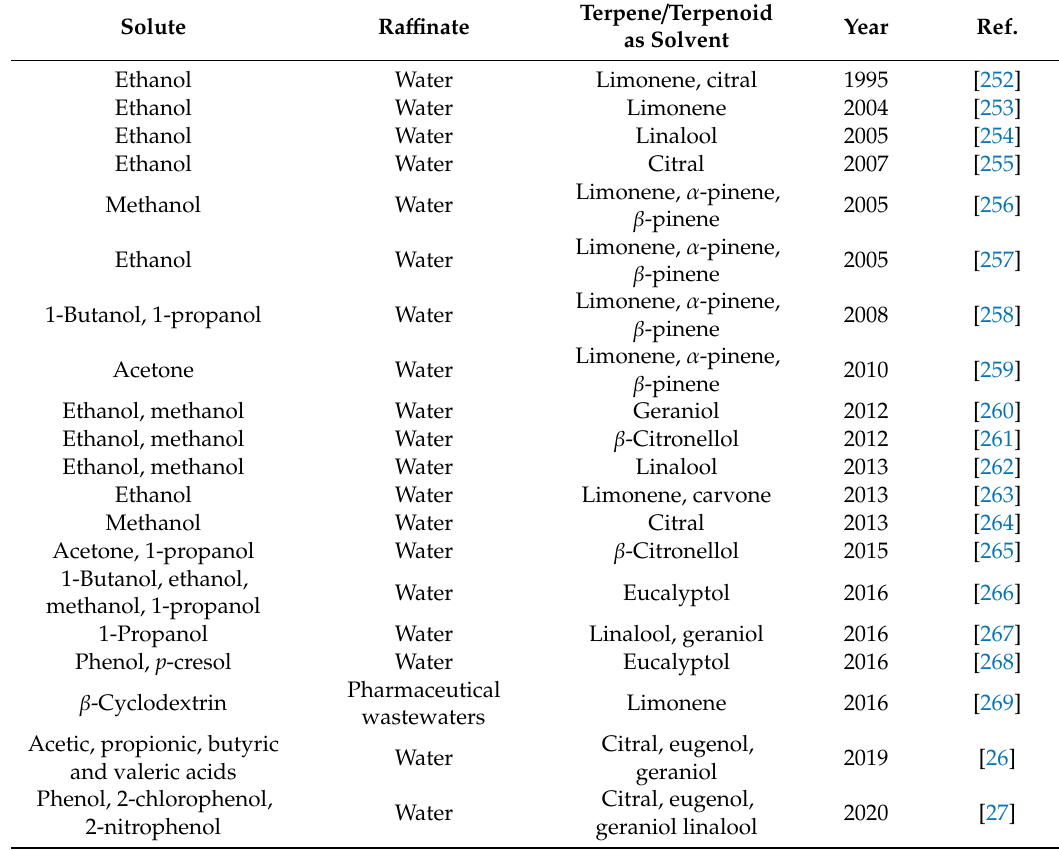
Table 12. Extraction Processes from Aqueous Solutions with Terpenes and